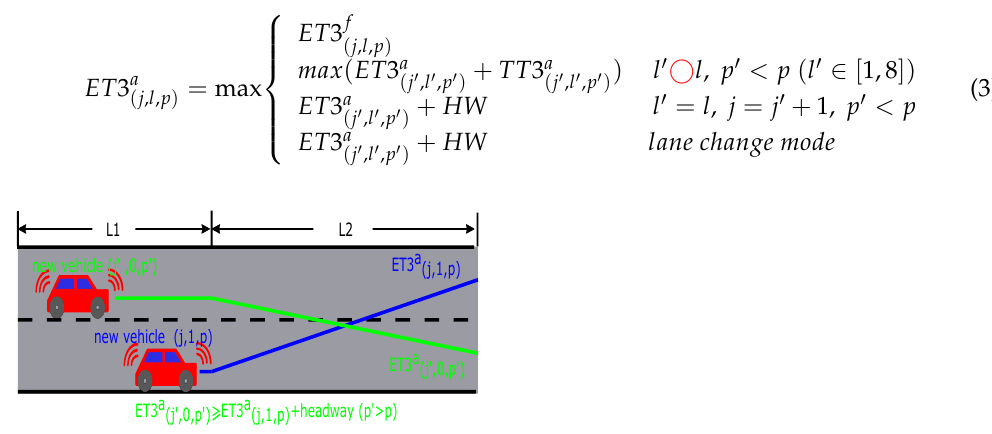
Figure 3. Lane change mode.